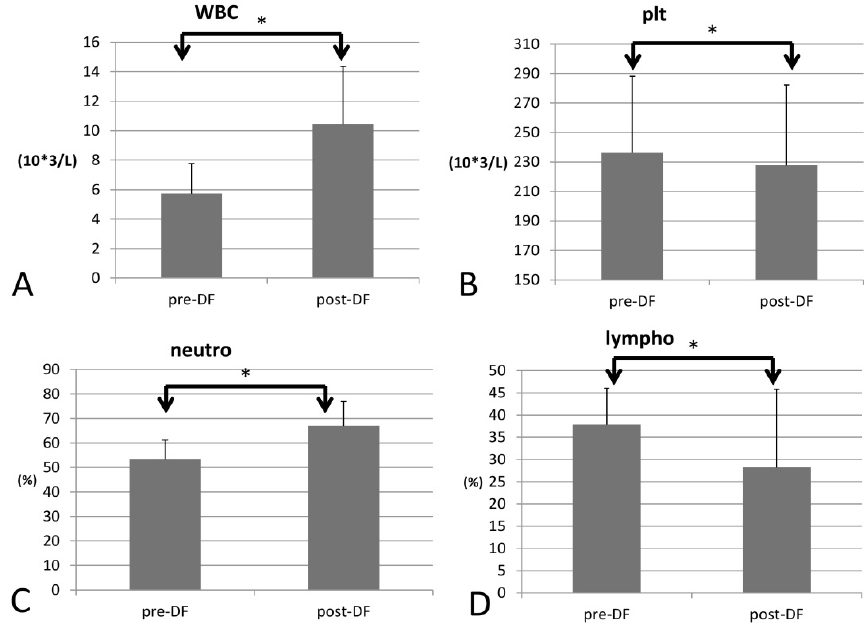
Figure 2. Changes in complete blood count (CBC) with increase of WBC ( A ) and decrease of platelet ( B ) and differential count (DC) with increase of neutrophil ( C ) and decrease of lymphocyte ( D ) before and after DF. (* for p < 0.05).